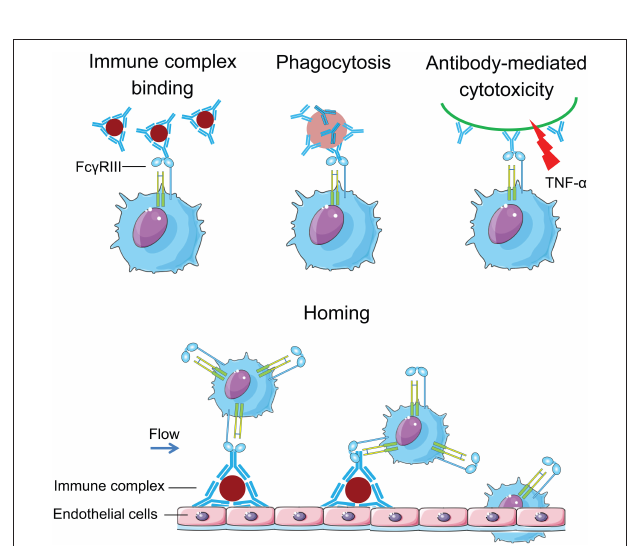
FIGURE 2 | CD16 equips slanMo with a strong capacity to handle complexed IgG: slanMo can bind to IgG immune complexes through CD16. They can also phagocytose and mediate antibody-mediated cellular cytotoxicity (ADCC) after binding of CD16 to antibody (IgG)- coated cells. This is in difference to monocytes expressing CD32 for engaging immune complexes. Moreover, slanMo in the blood flow can home to immobilized vascular immune complexes via